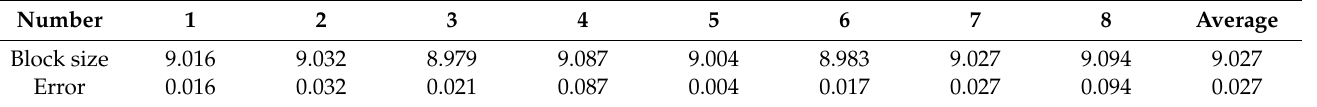
Figure 7. Measurement results of block length: ( a ) The 1st experiment, ( b ) the 4th experiment, and ( c ) the 8th experiment. Table 1. Block pixel size measurement results Table 1. Block pixel size measurement results (mm) .